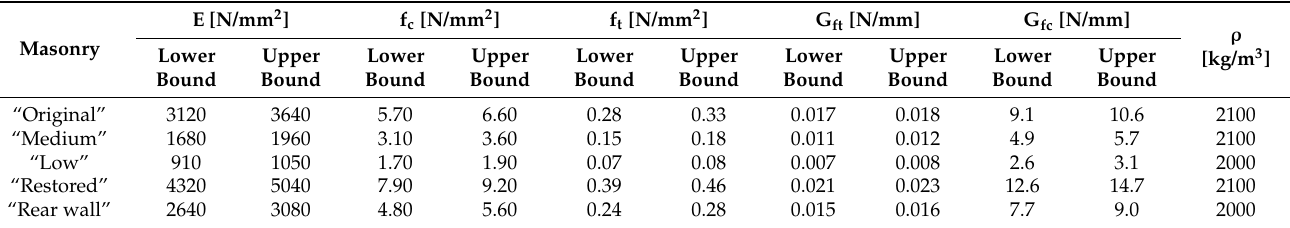
Table 3. Nonlinear material properties of the different qualities of masonry considered in the numerical